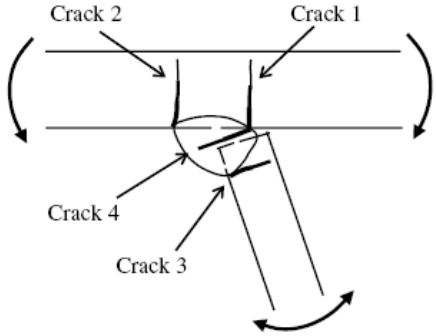
Figure 3: Fatigue cracks at rib-to-deck plate connection (Xiao,